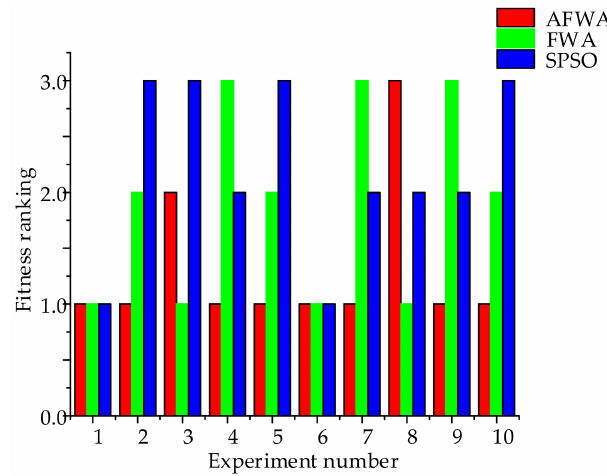
Figure 10. Algorithm fitness ranking of the first case.